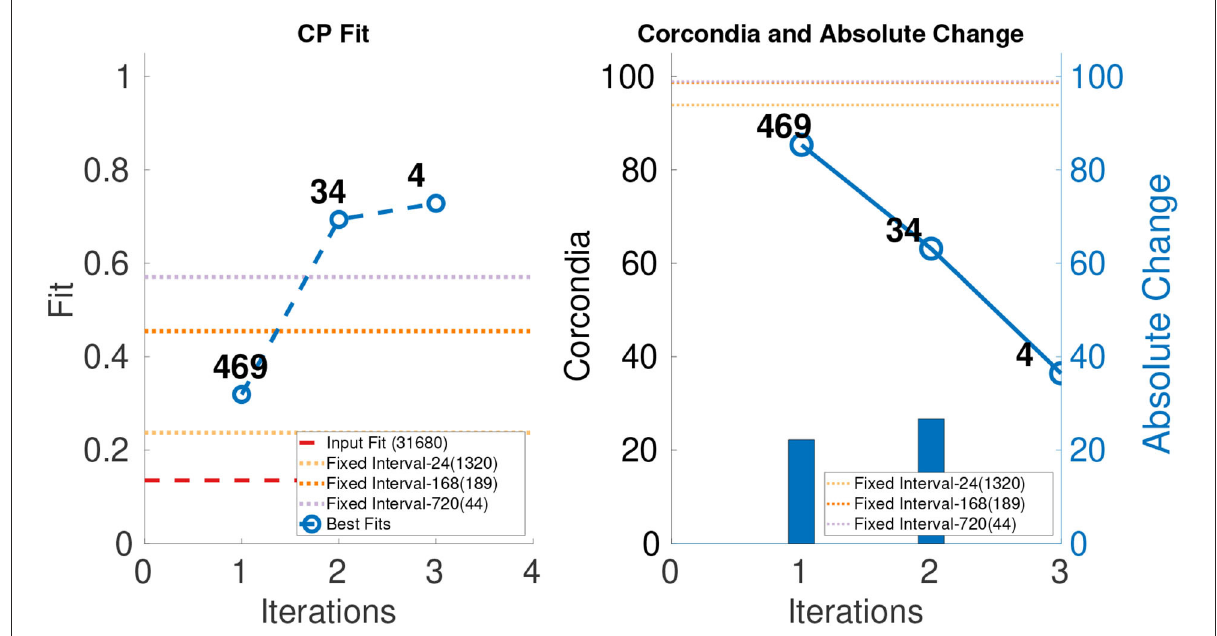
FIGURE7 CP fit and CORCONDIA of best fit tensor and its absolute change at each iteration for Enron Hourly.